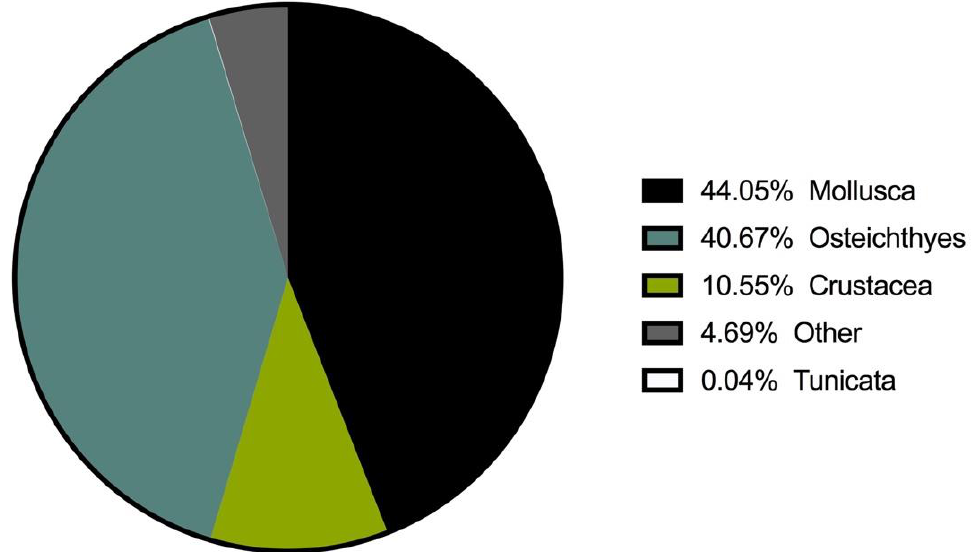
Figure 6. Diet composition by weight (%W) of G. melastomus . The percentage of biomass composition of main prey categories is summarized on the right of the figure. “Other” indicates unidentified prey and sea bird remains.